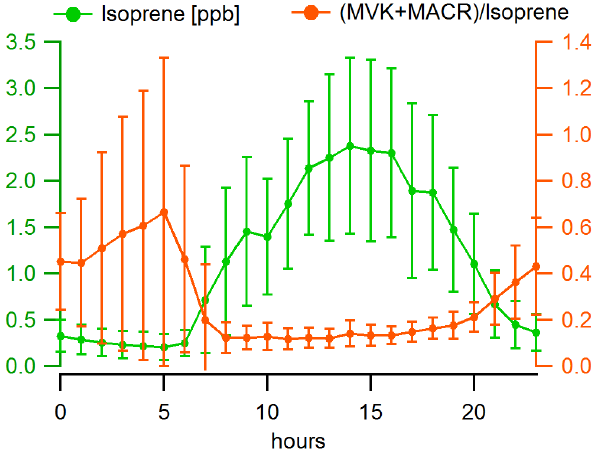
Figure 8. Averaged diel cycles of isoprene concentrations and [MVK + MACR]/isoprene ratio measured above the canopy of the O 3 HP from 4 to 16 June. Vertical bars do not show error but stan- dard deviation to the mean